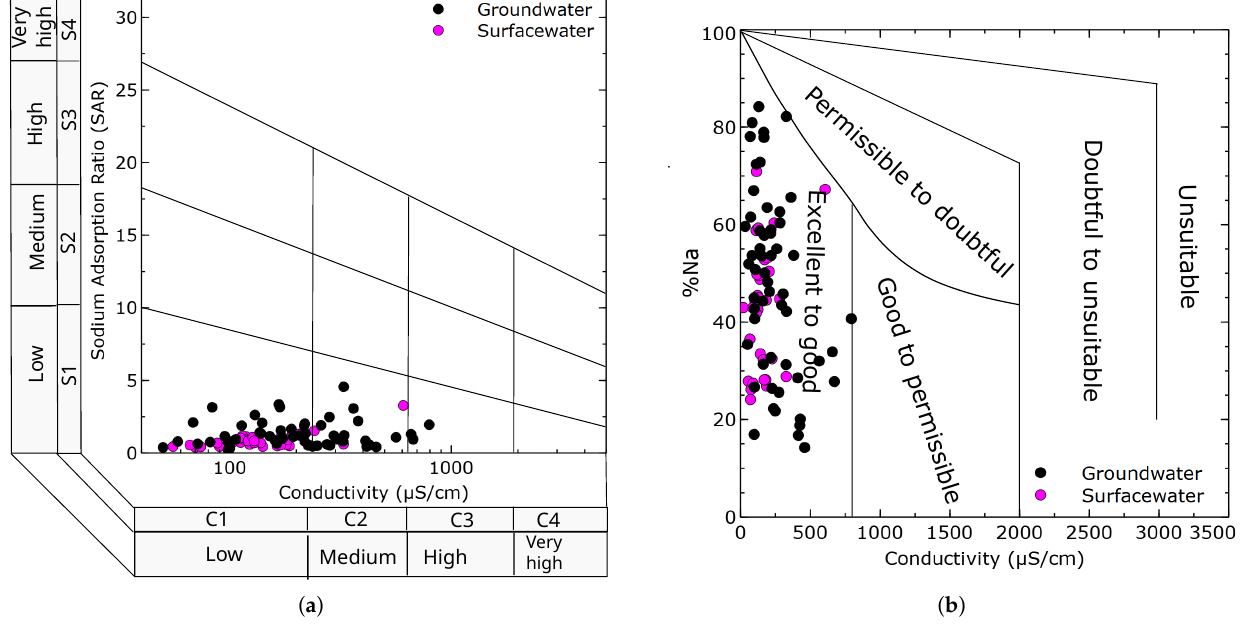
Figure 5. Irrigation water classification diagrams showing surface water and groundwater quality acceptable for irrigation ( a ) USSL classification [36] and ( b ) Wilcox classification [44]. For irrigation quality assesment, the SAR, USSL and Wilcox diagram show that all groundwater samples fall into the good to excellent irrigation water category. The